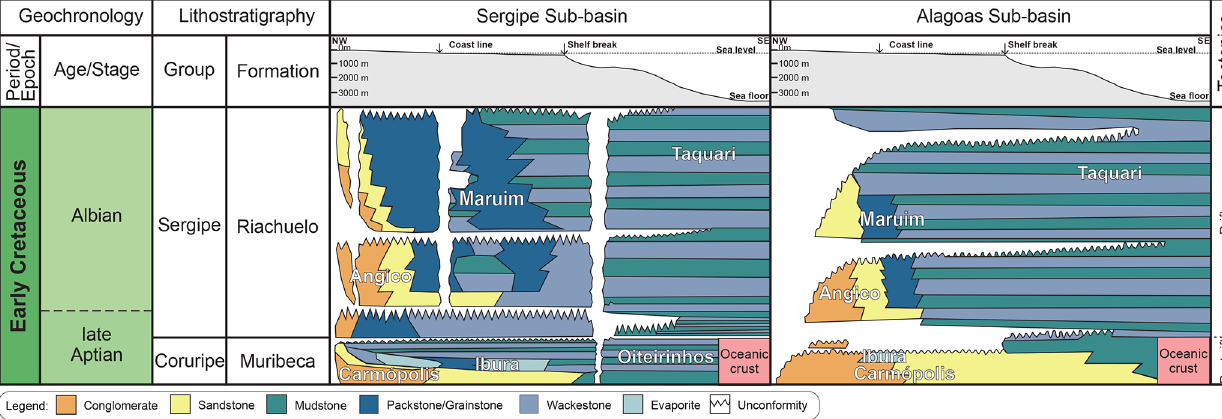
Figure 3. Lithostratigraphic chart of the late Aptian–Albian interval deposits of the Sergipe–Alagoas Basin (e.g., Schaller, 1969; Campos Neto et al., 2007; Bengtson et al., 2018).